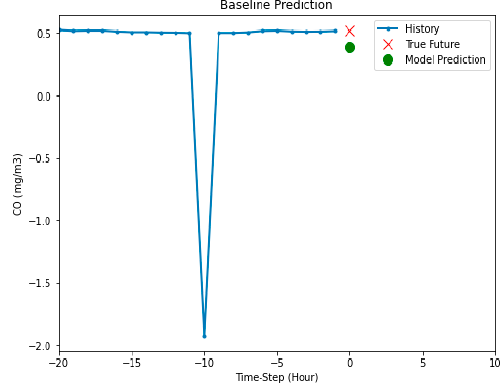
Figure 9. Prediction performed by univariant model.